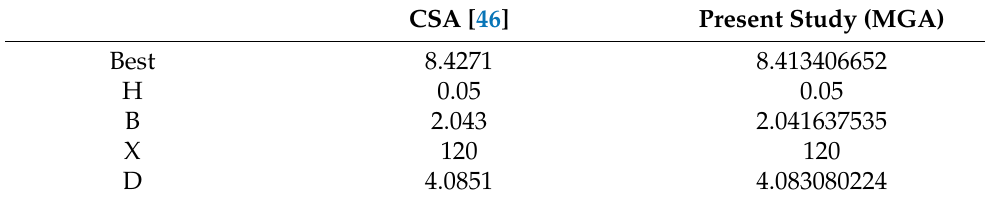
Table A19. Comparison of the best solutions for the piston lever design problem.